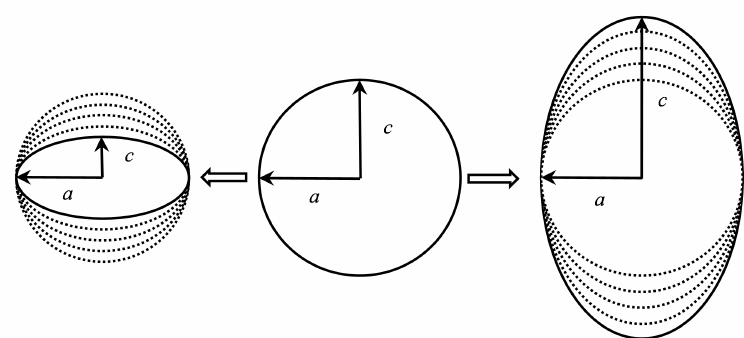
Figure 14. Schematic of shells with different ratios between the a and c